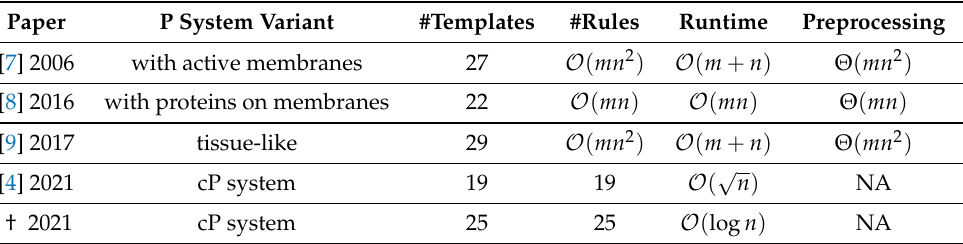
Table 1. Ruleset size and runtime for several proposed P system solutions. † = this paper. The preprocessing time was only estimated by